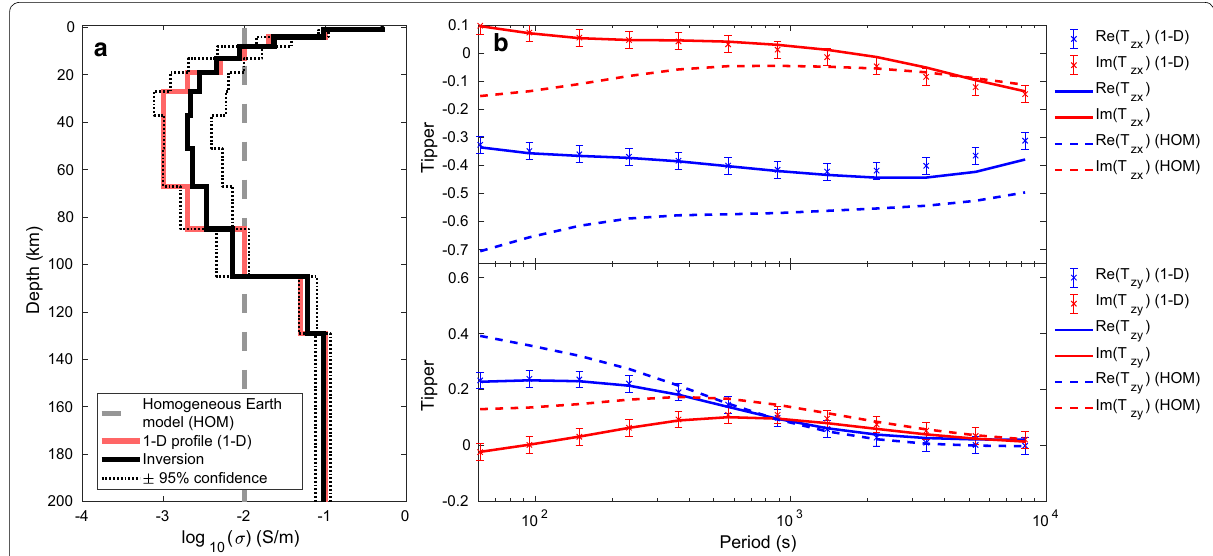
Fig. 2 Short title: Synthetic test Detailed legend: a Conductivity profiles and b corresponding tippers for TDC bathymetry are shown for two synthetic conductivity profiles: a homogeneous Earth model [(HOM, dashed gray line ( a ) and dashed colored lines ( b )], and a profile varying with depth (1-D, red line ( a ) and symbols ( b )). The synthetic tippers that correspond to the 1-D profile were inverted with 3% added noise and resulted in a the solid black conductivity profile and b the tippers shown by solid colored